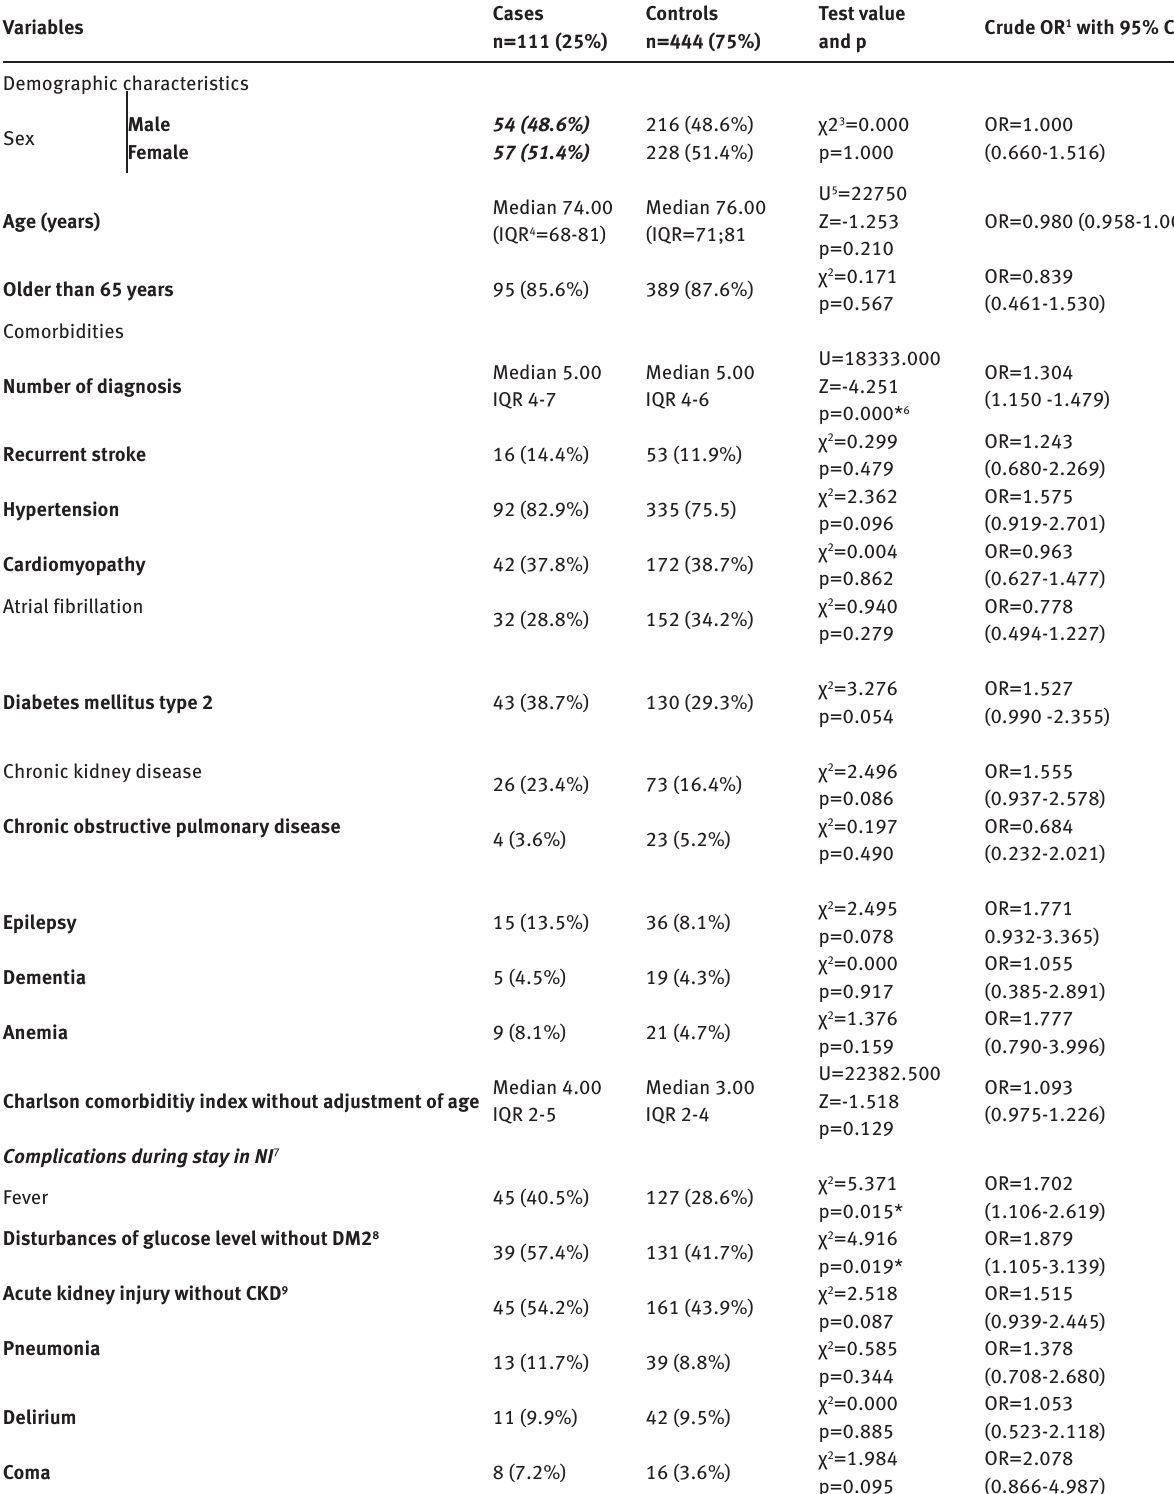
Table 4A: Baseline demographic and clinical characteristics of cases and